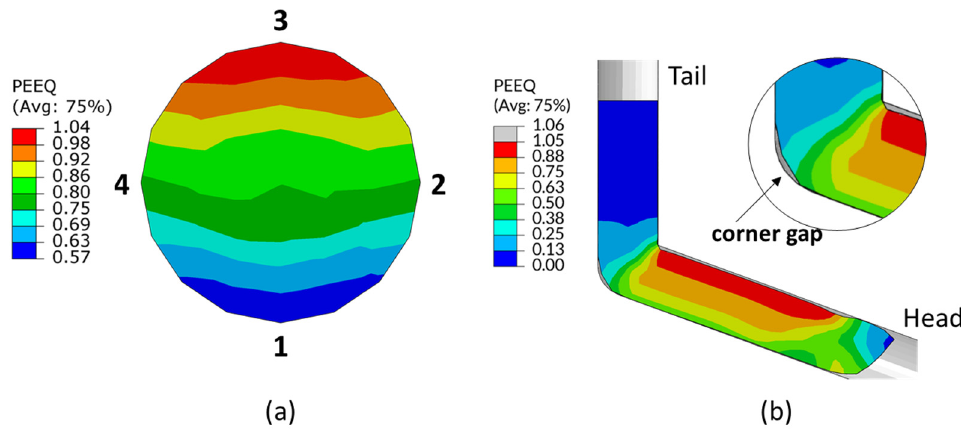
Figure 5. Equivalent plastic strain distribution contours for ( a ) transverse cross-section and ( b ) longitudinal direction through ECAP for one pass.